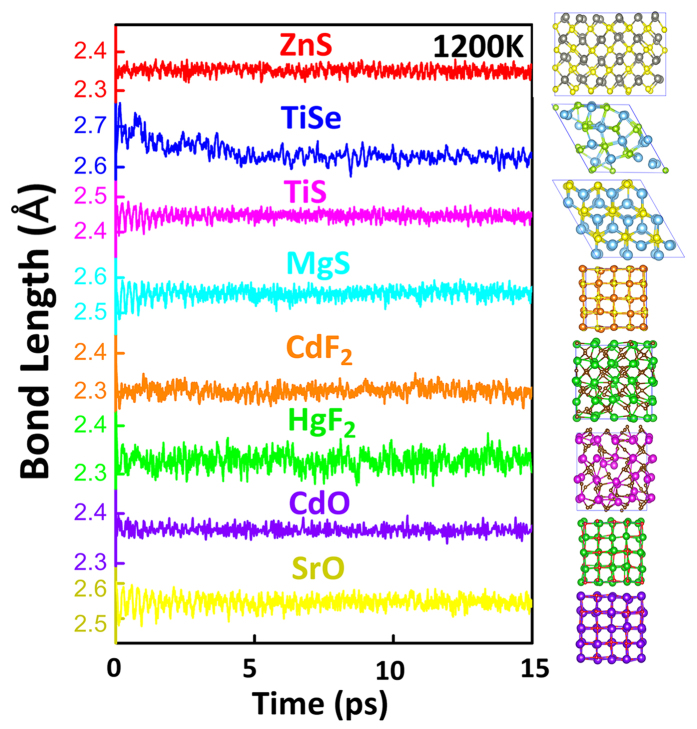
Bond-length evolutions of TiSe, TiS, MgS, CdF2, HgF2, CdO and SrO in 15-ps molecular dynamics at 1200 K.The final snapshot of the crystal structure after 15-ps annealing is shown together with its bond-length evolution.